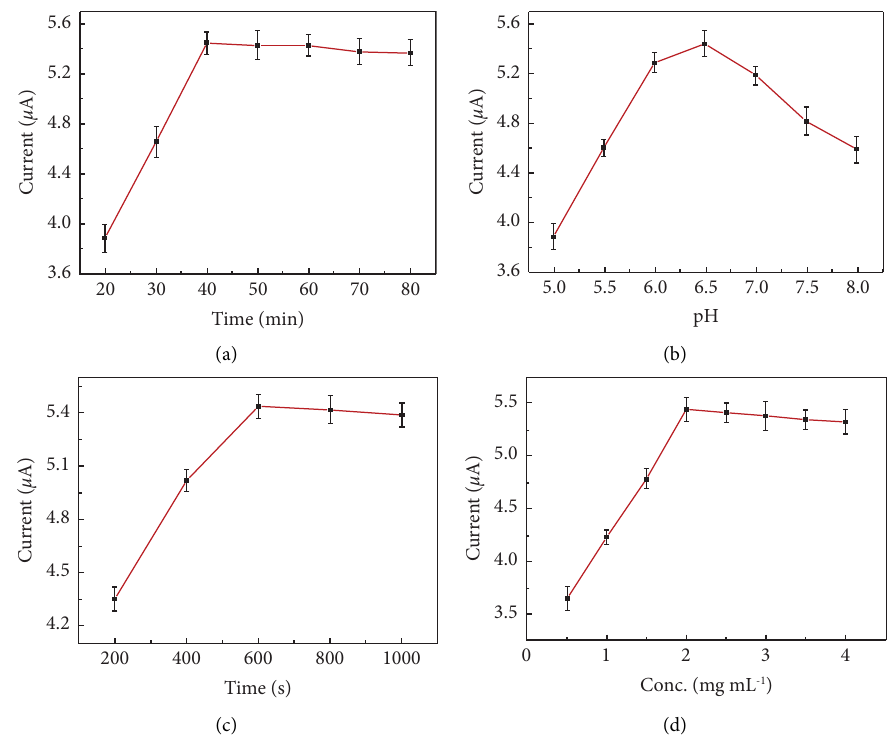
Figure 3: Infuence of (a) incubation time, (b) pH, (c) deposition time of AuPt NFs, and (d) the concentration Au NPs/PB@PANI on the peak currents to C CEA � 10.0ng · mL − 1 . Error bars represent standard deviations from fve repeated measurements.